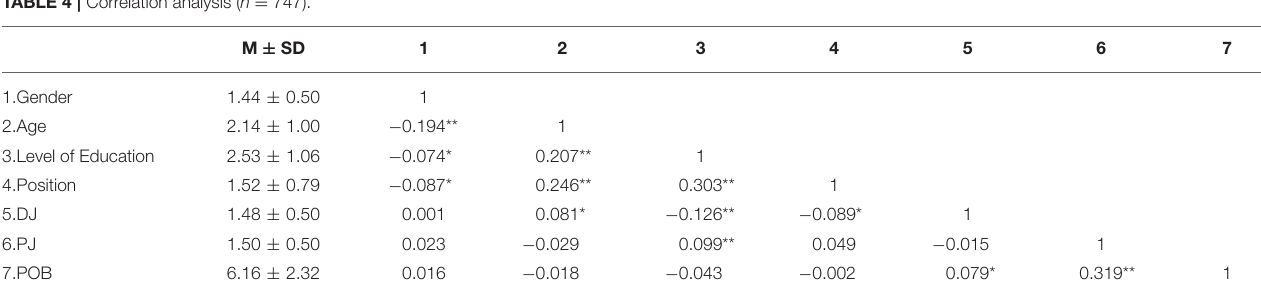
TABLE 4 | Correlation analysis ( n =